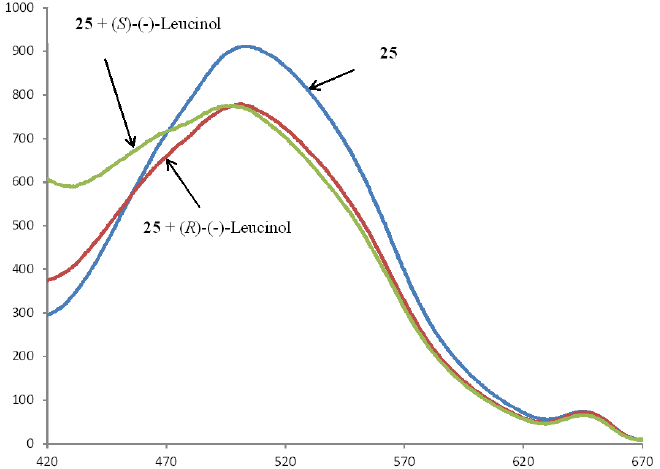
Figure 12. Fluorescence spectra of compound 24 in the presence of ( R )- and ( S )-enantiomers of Sensors 2020 , 20 , x FOR PEER REVIEW leucinol (1000 equiv.). (1000 equiv.).